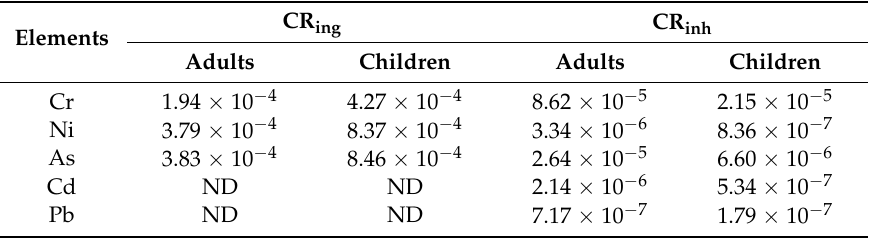
Table 2. The carcinogenic risks via ingestion (CR ing ) and inhalation (CR inh ). Acceptable values of CR are between 1 × 10 − 6 and 1 × 10 − 4